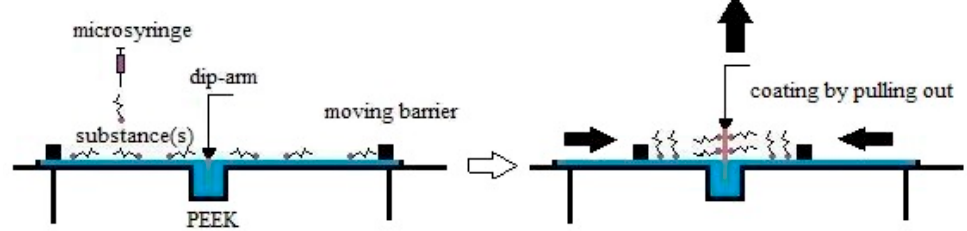
Figure 3. The scheme of coating solid supports using the Langmuir-Blodgett technique by pulling out.